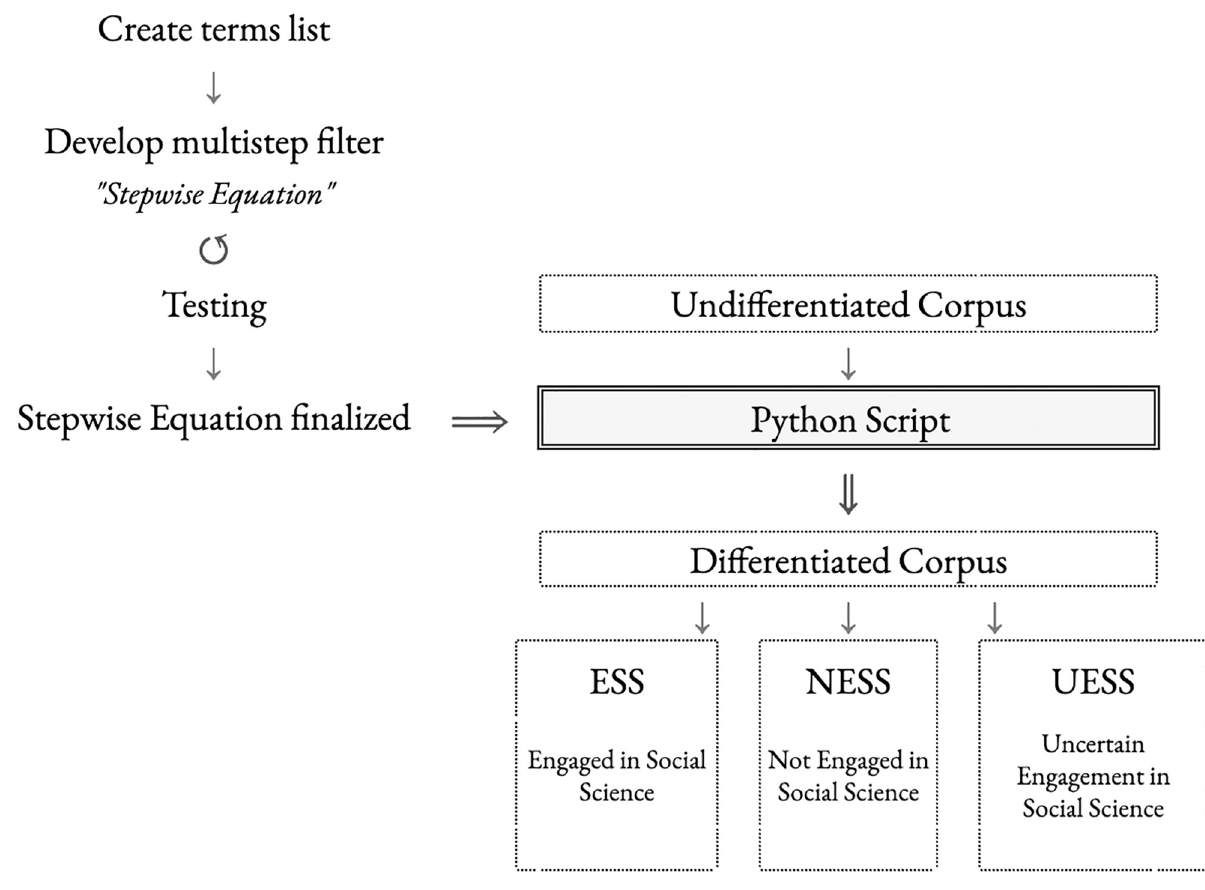
Fig 1. An overview of the SEAC